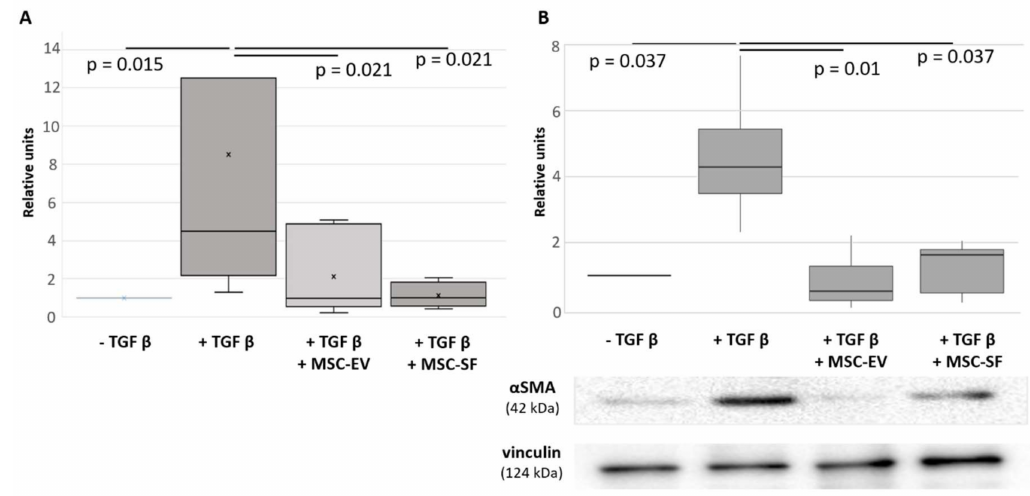
Figure 1. Mesenchymal stem / stromal cells conditioned medium (MSC-CM) fractions added simultaneously with transforming growth factor-beta (TGFbeta) prevented the TGFbeta-induced increase of aSMA expression in fibroblasts. Analysis of aSMA expression in serum-free cultured control fibroblasts ( − TGFbeta), in fibroblasts after exposure to TGFbeta ( + TGFbeta) and TGFbeta with the components of MSC-CM ( + TGFbeta + MSC-EV; + TGFbeta + MSC-SF). ( A ) RT-PCR ( n = 9). ( B ) Western blotting ( n =